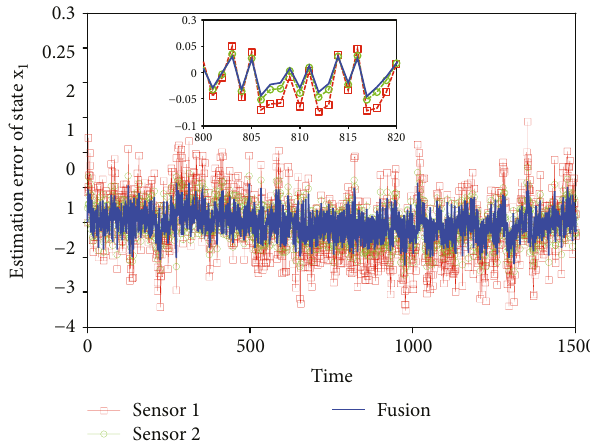
1 (sensor 1, sensor 2, and fusion)